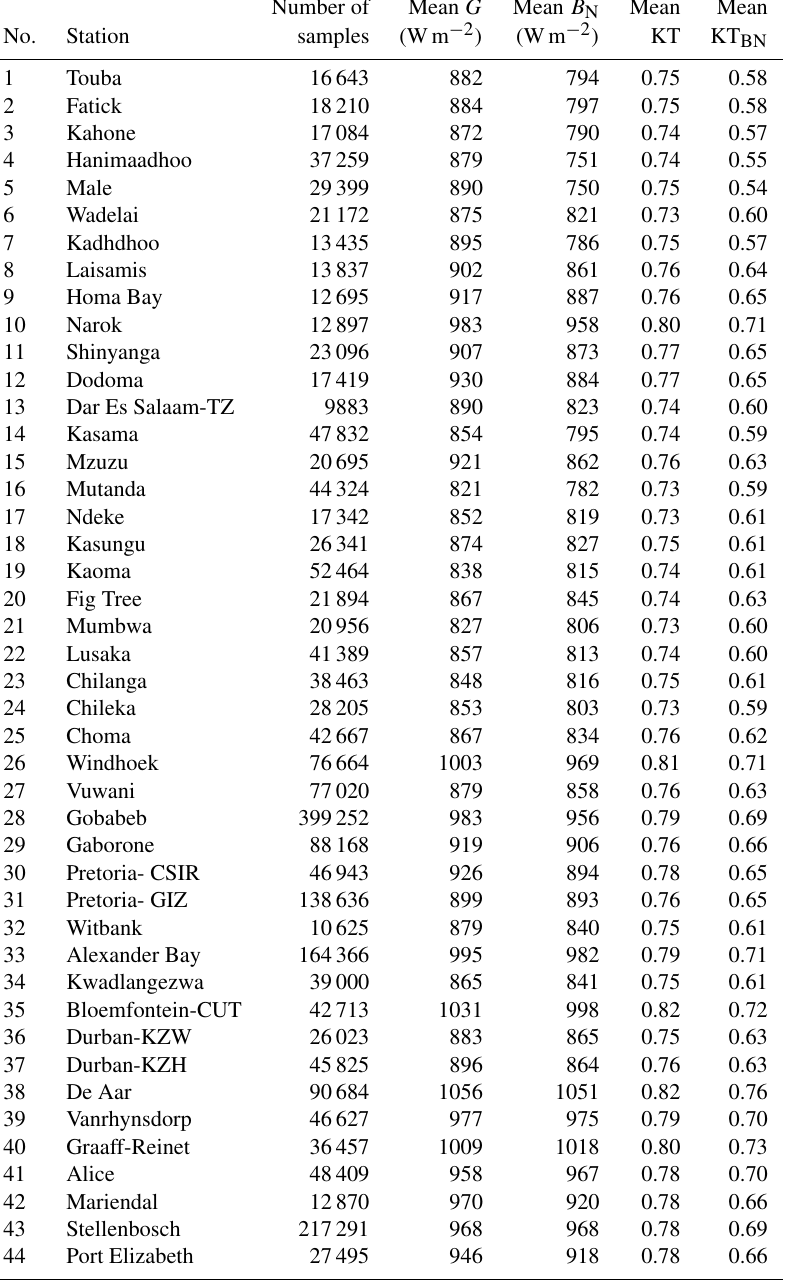
Table 4. Number of samples for validation, along with the means of G , B N , KT, and KT BN at each station for the ensemble of retained years.